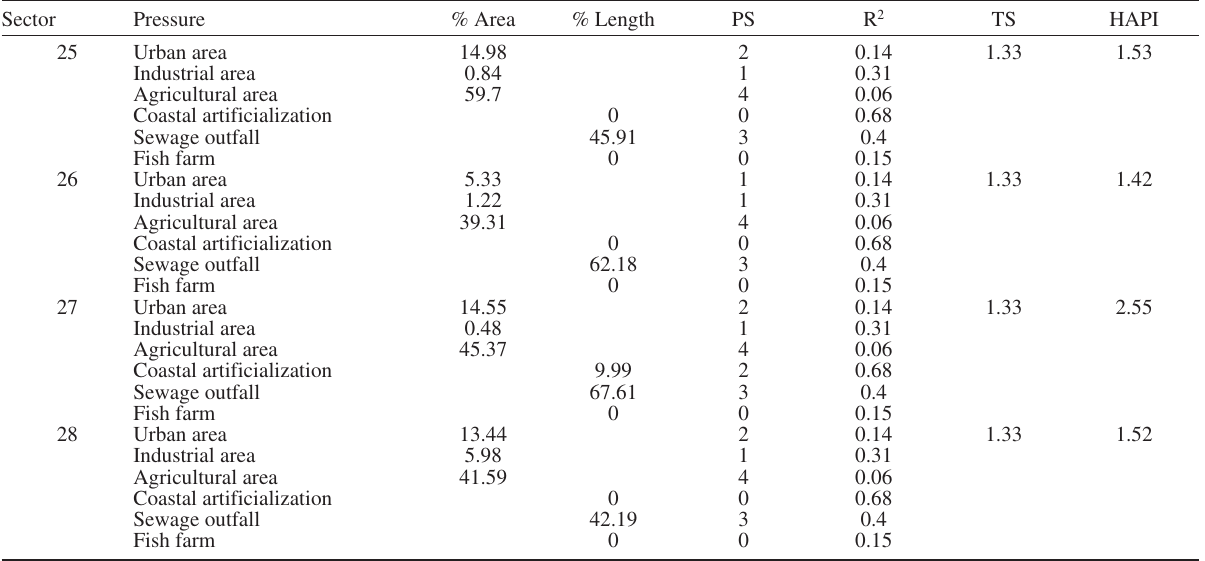
Table S3 (Cont.). – Percentages of the area and length of each sector according to human pressure. Pressure scores (PS) assigned to each pressure are indicated. Correlation coefficients (R 2 ) between pressures, turnover score (TS) and the HAPI index (HAPIj= Ʃ (PSi×ri)/TSj) were calculated according to Blanfuné et al.